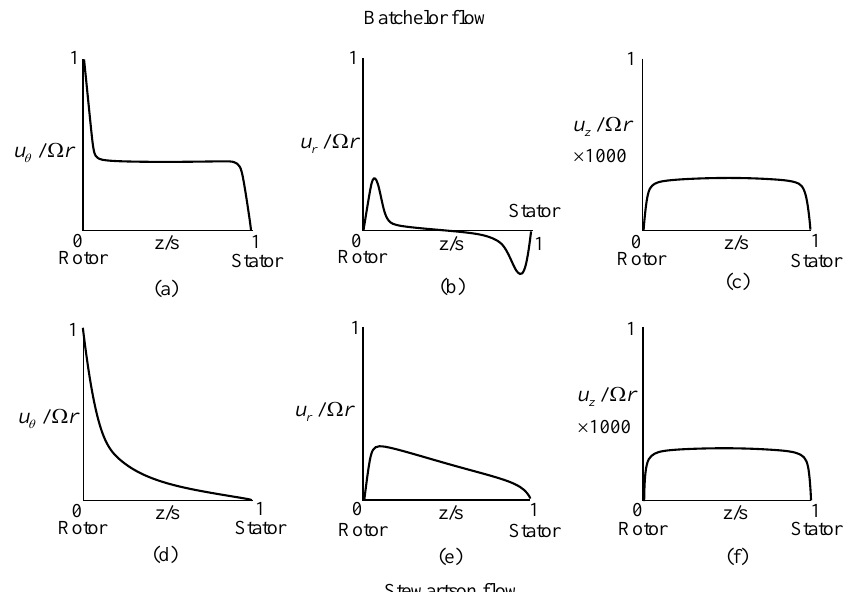
Figure 3. Sketches of the characteristic velocity profiles in a rotor-stator system. ( a – c ) are of the Batchelor type and ( d – f ) of the Stewartson type